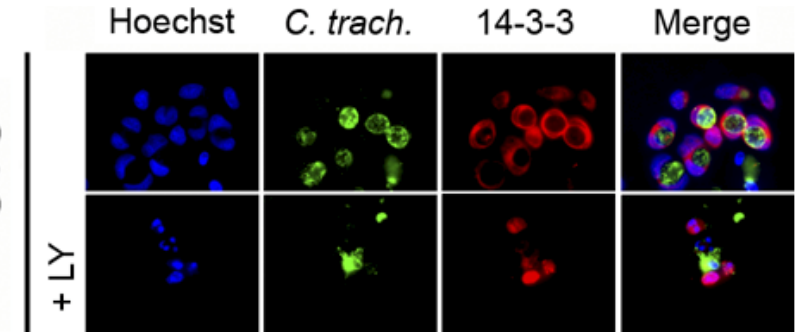
Figure 8. Localization of 14-3-3 b in C. trachomatis -Infected Cells Cells expressing endogenous levels of BAD were infected with C. trachomatis at an MOI of 1.0 for 26 h, and then incubated with 50 l M LY294002 (LY) or control buffer for 6 h before treating with 2 l M STS overnight. DNA was revealed with Hoechst (blue), Chlamydia with FITC-conjugated anti- Chlamydia antibody (green), and 14-3-3 with Texas Red-conjugated anti-14-3-3 antibody (red), as described in Materials and Methods. 14-3-3 is localized primarily on the Chlamydia vacuole in infected cells, even in the presence of STS (top row). The co-localization of 14-3-3 and the Chlamydia vacuole is lost in infected cells that had been pre-incubated with LY294002 before STS treatment (bottom row). One experiment of three representative experiments performed on separate days is shown. DOI: 10.1371/journal.ppat.0020045.g008